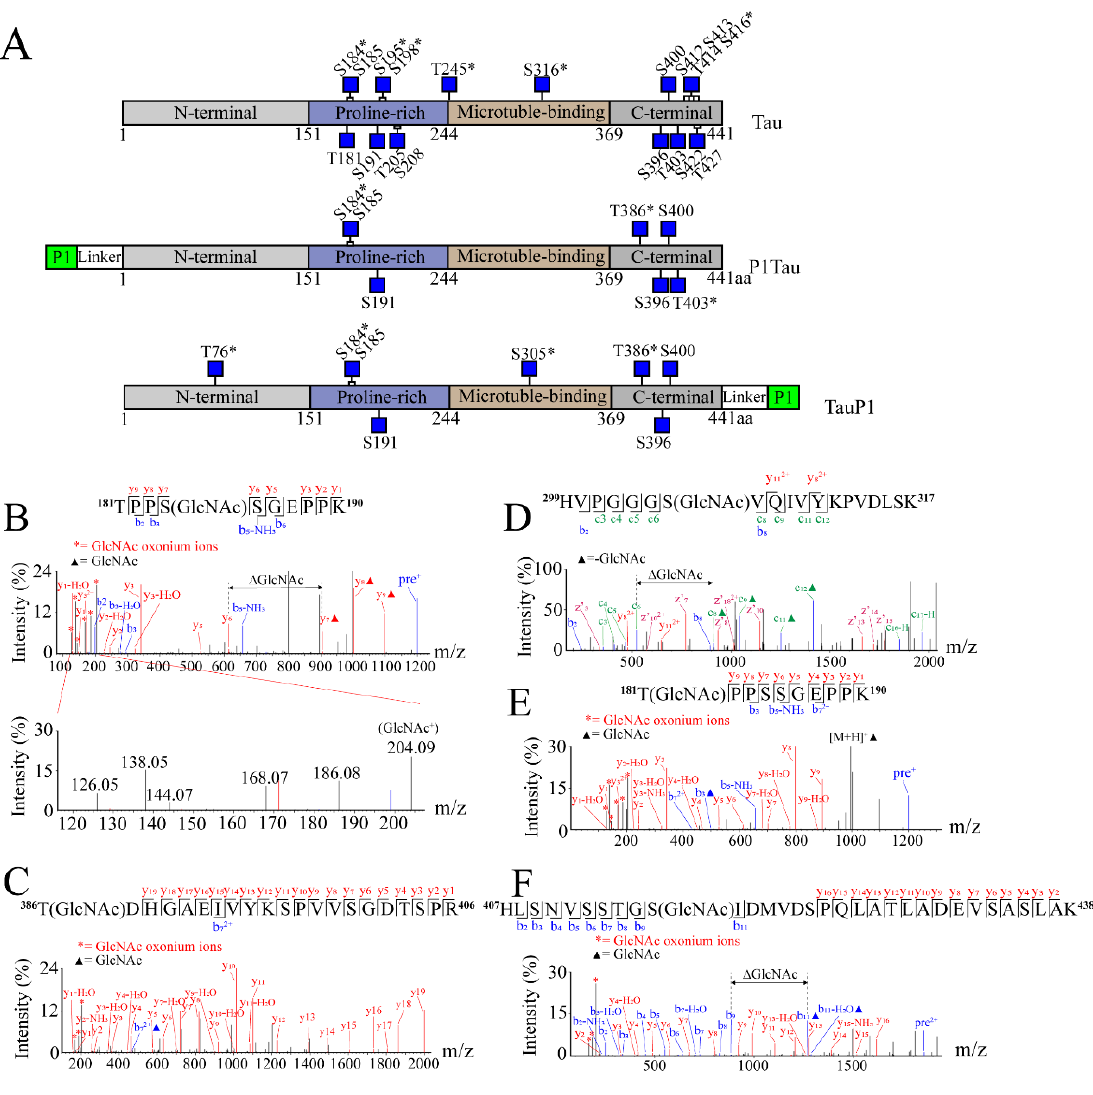
Figure 2. O-GlcNAc sites of Tau, P1Tau, and TauP1 were identified using MS. ( A ) Schematic structures of Tau, P1Tau, and TauP1 with O-GlcNAc-modified residues indicated as blue squares, and novel sites indicated with asterisks (*). HCD/ETD spectra reveal some new O-GlcNAc sites on the following peptides: ( B ) 181 TPP S SGEPPK 190 (P1Tau), GlcNAc oxonium ions (126.06, 138.06, 144.07, 168.07, 186.08 m / z, and 204.09 m / z ) are shown in the lower panel of spectrogram; ( C ) 386 T DHGAEIVYKSPVVSGDTSPR 406 (P1Tau); ( D ) 299 HVPGGG S VQIVYKPVDLSK 317 (TauP1); ( E ) 181 T PPSSGEPPK 190 (Tau); ( F ) 407 HLSNVSSTG S IDMVDSPQLATLADEVSASLAK 438 (Tau). All of the modification sites are shown in underlined letters. Double-headed arrows and ∆ GlcNAc indicate the mass shift of the O-GlcNAc moiety between key fragment ions. Oxonium ions are labeled with red asterisks. Solid triangles represent the presence of GlcNAc modification on the peptide ions and fragment